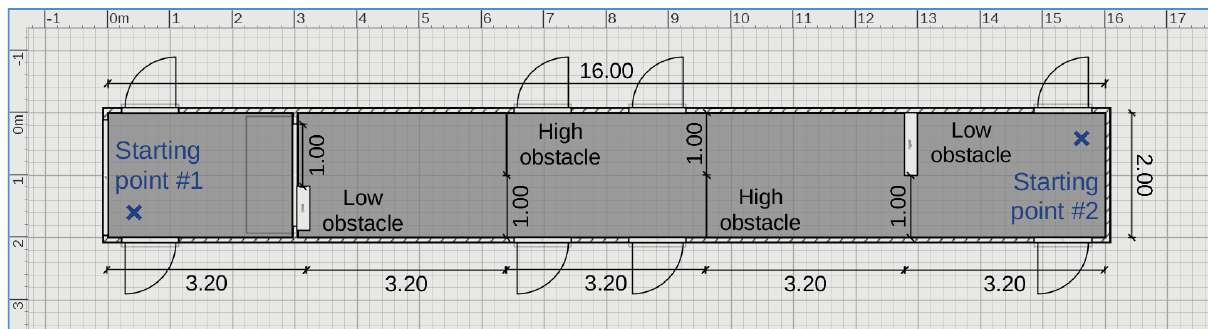
Figure 16. A diagram of the corridor with the obstacles in the path. The two possible orientations with starting point labeled with a blue cross and a “starting point” for each case. The total length was 16 m and with was 2 m. The space between obstacles was 3.2 m. On the left side, a double-leaf door is also drawn, which was left open during the